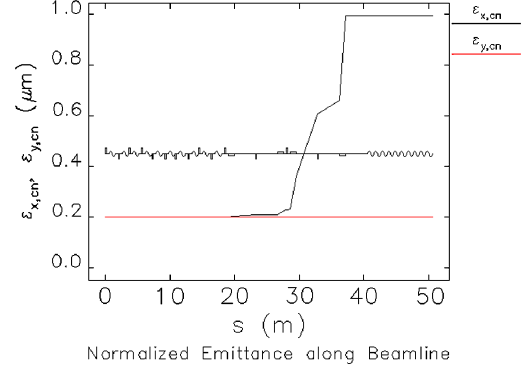
FIG. 3. The evolution of e-beam emittance in the bunch com- pressor using a single chicane. The blowup of emittance is caused by the CSR effect.